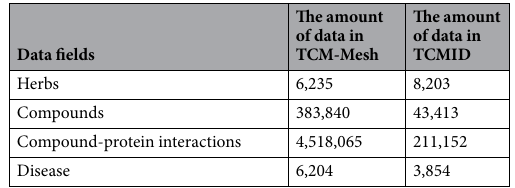
Table 1. Comparisons of data sizes between TCM-Mesh and TCMID. Comparisons were made from four aspects: herbs, compounds, diseases and compound-protein interactions by comparing the size between TCM- Mesh and TCMID.